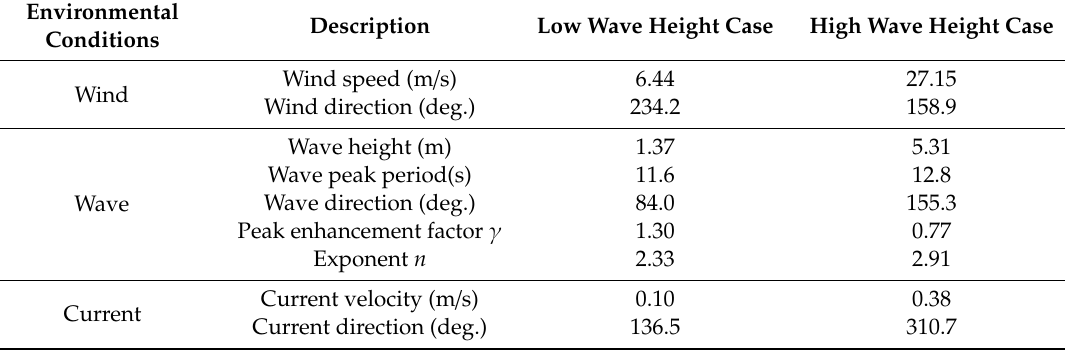
Table 5. Description on the wind, wave and current conditions at the Fukushima site used in this study.